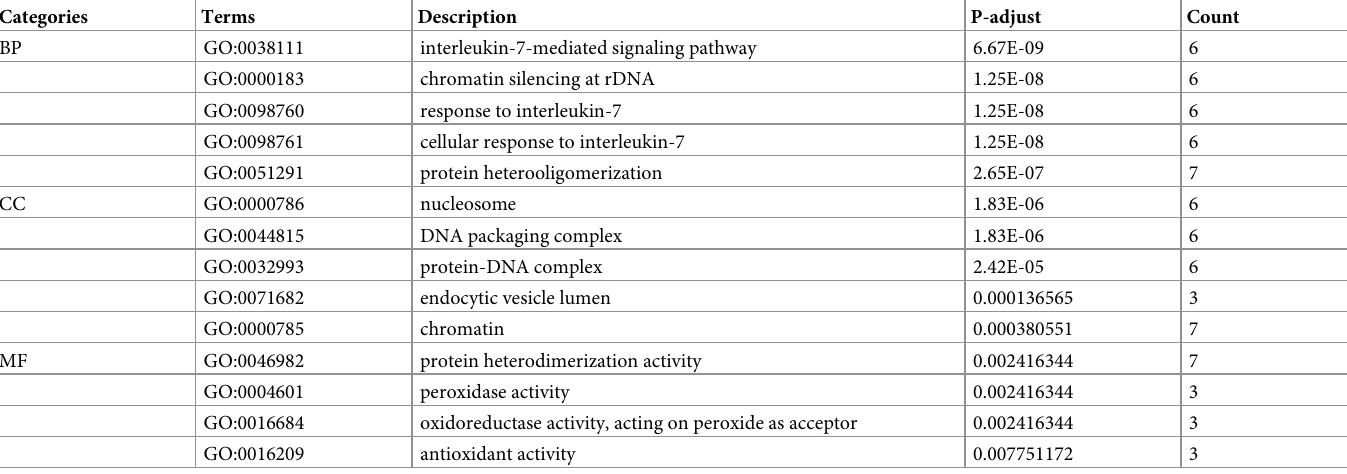
Table 4. GO analysis for differential mRNAs in the competing endogenous RNA